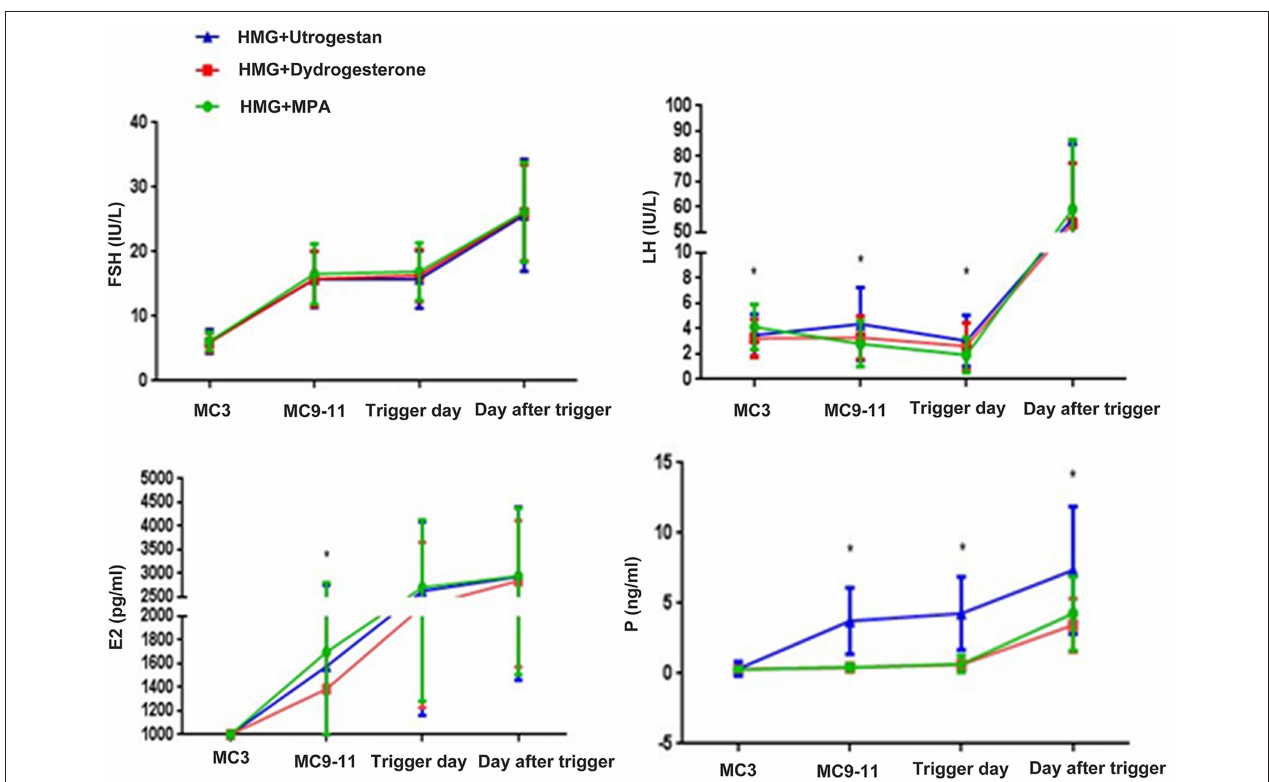
FIGURE 2 | Hormone profiles in the three groups. The mean ± SD values show the temporal associations among circulating concentrations of follicle-stimulating hormone (FSH), luteinizing hormone (LH), estrogen (E 2 ), and progesterone (P). The green line shows the MPA + HMG group, the red line refers to the dydrogesterone + HMG group, and the blue line refers to the progesterone + HMG group. * P < 0.05 at the time